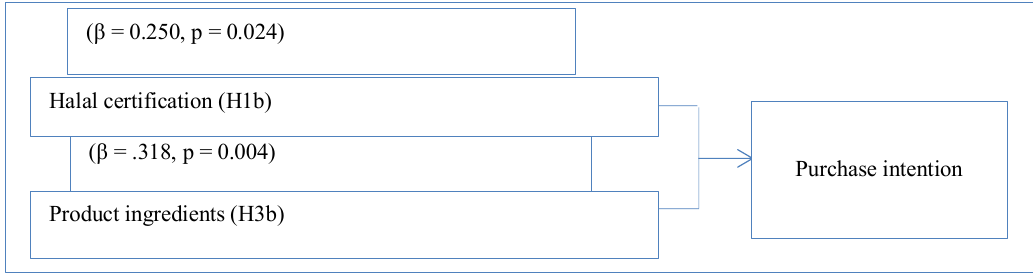
Figure 3: Factor influencing Indonesian Muslims’ intention to purchase non-Muslim’s halal packaged food